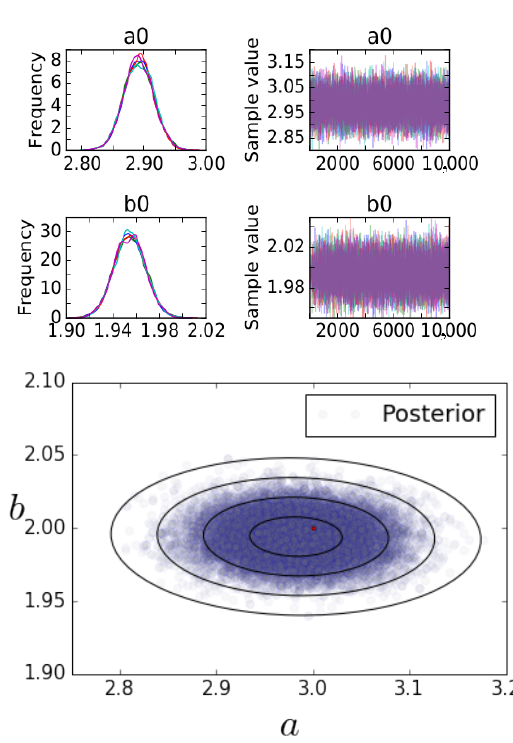
Figure 9. Top panel: One-dimensional marginalized posterior distributions for our samples and the Markov chains for model H 0 . Bottom panel: Two-dimensional marginalized posterior distributions, along with 1–4 confidence regions for our parameters for model H 0 . The red point corresponds to the true value.